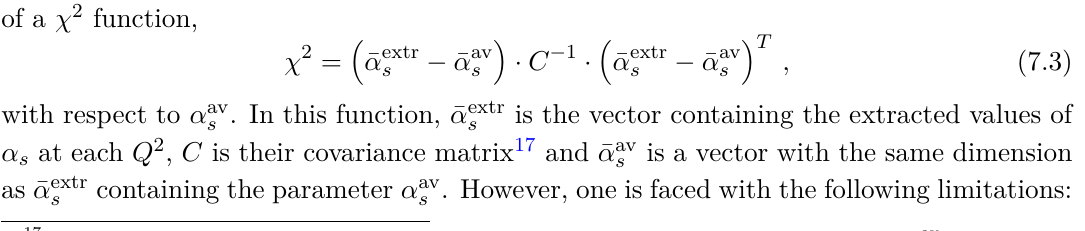
Figure 19 . Comparison between the lattice FLAG average α ( n f =5) s ( M 2 the values of α s obtained at each Q 2 for the R ( s ) and lattice Adler